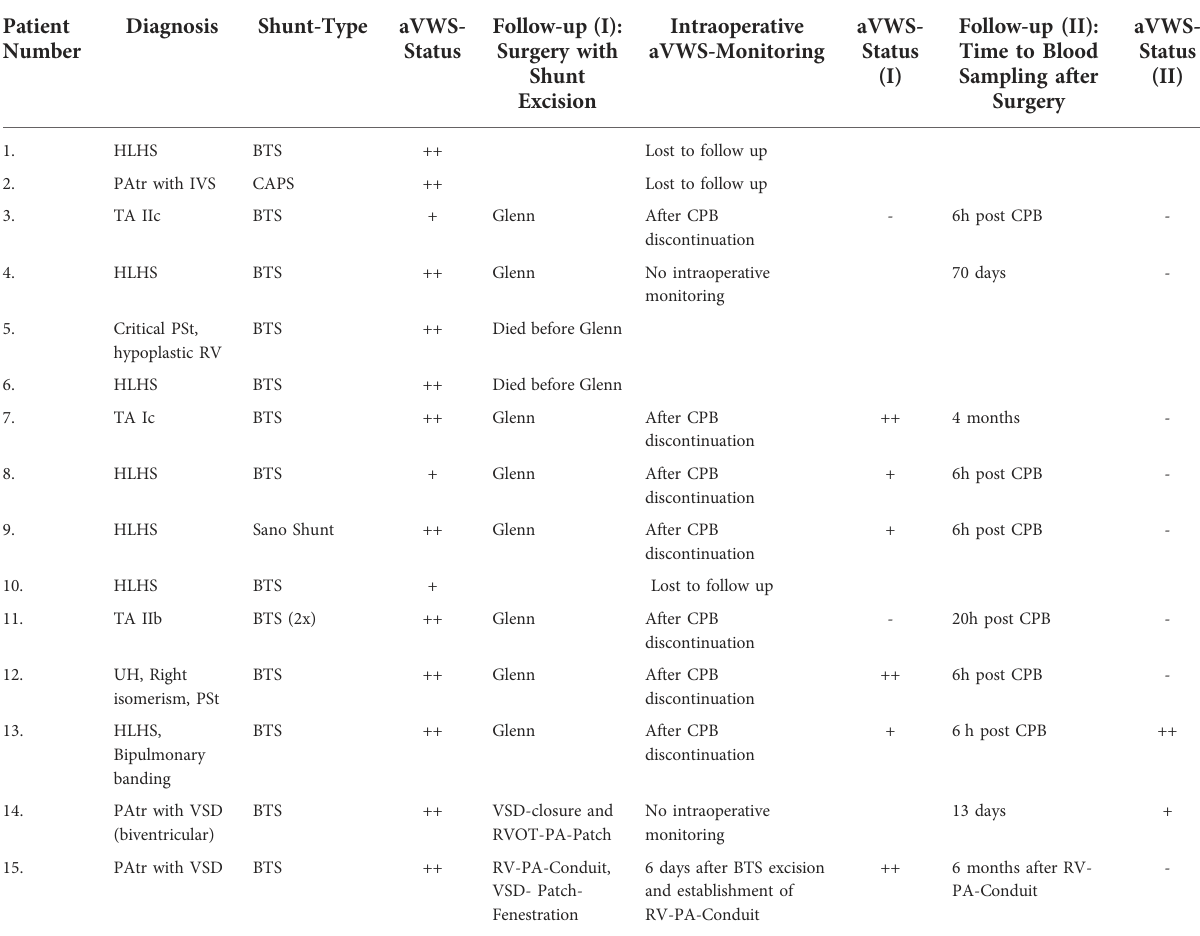
TABLE 1 Patients ’ characteristics and aVWS